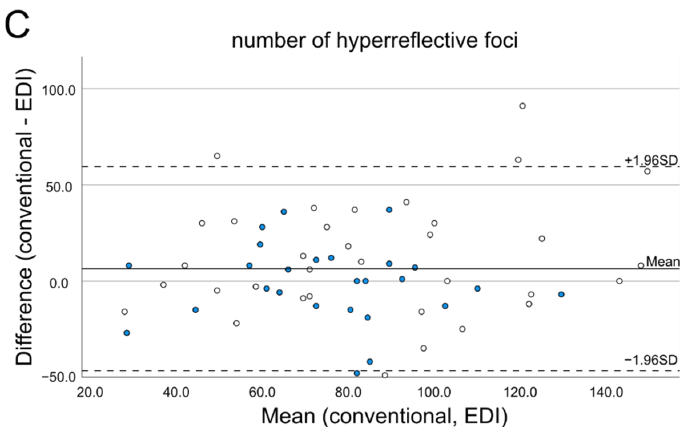
Figure 2. Bland–Altman plots show the differences of quantification of hyperreflective foci ( A ), ellipsoid zone reflectivity ratio ( B ) and choroidal vascularity index ( C ) in OCT scans with and without EDI mode. ( A – C ) White and blue dots represent patients with macular edema and without macular edema on the day of imaging. Dashed lines indicate upper and lower limits of agreement (LoA), black line represents mean or median.